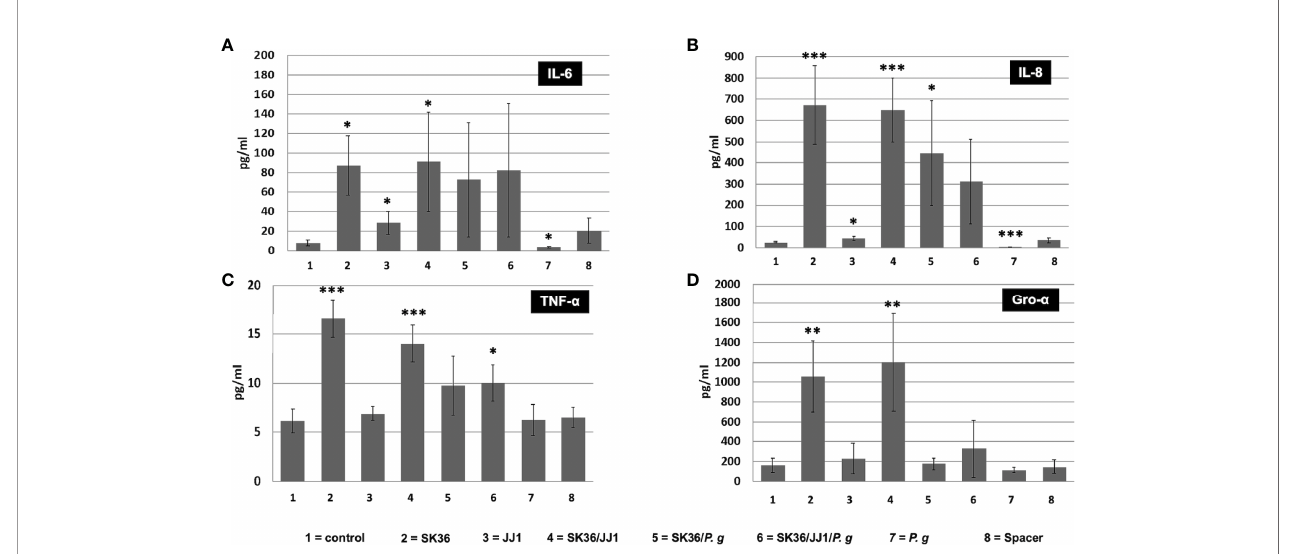
FIGURE 5 | . Cytokine response of immortalized human gingival keratinocyte cell line hTERT-TIGKs. Supernatants were collected 6 h after bio fi lm challenge. The protein abundance (pg/ml) of CXCL8/IL-8, TNF- a , IL-6, and CXCL1/GRO- a was determined using a Magnetic Luminex Assay. Unchallenged cells (no spacer, “ control ” ) and the spacer placed onto the con fl uent cell layer ( “ spacer ” ) served as controls. (A) IL-6; (B) IL-8; (C) TNF- a ; (D) Gro- a . Data represent the averages and standard deviations of at least 3 biological replicates. Statistical differences are shown as comparison to the no spacer-control (1=column). * P ≤ 0.05; ** P ≤ 0.01; *** P ≤